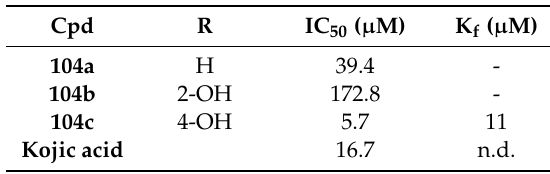
Table 16. Substituents, mushroom tyrosinase inhibitory activity, IC 50 ( µ M) and kinetics of compounds 104a–c